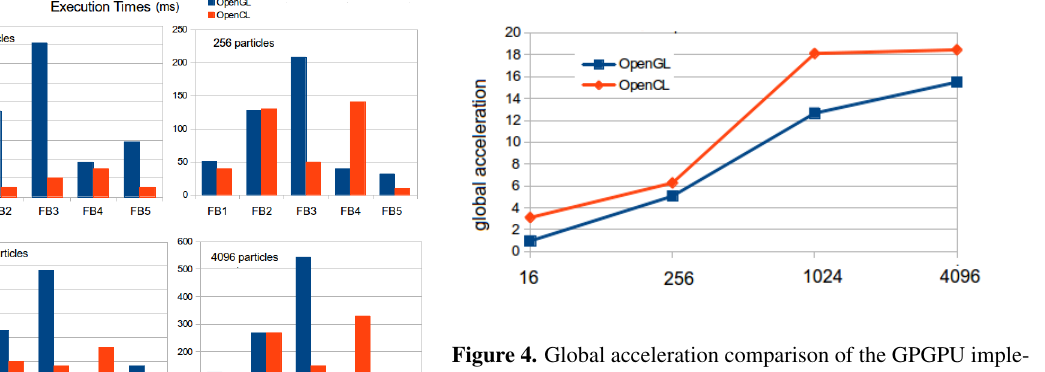
Figure 4. Global acceleration comparison of the GPGPU imple- mentation between OpenCL, OpenGL